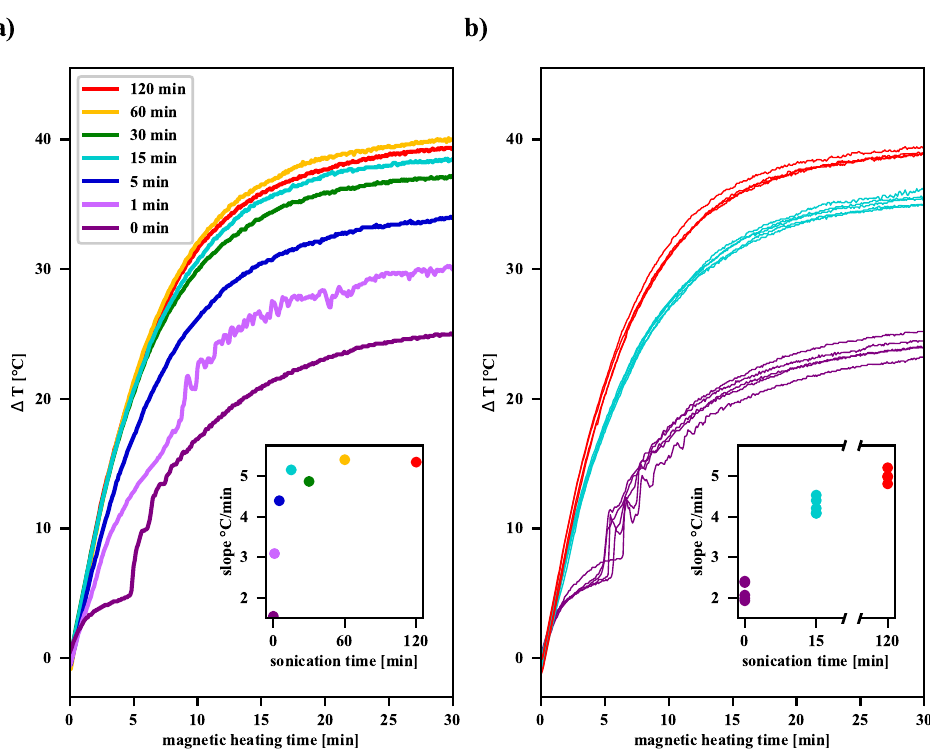
Figure 4. Both panels show how ∆ T changes during the RFMH process for suspensions treated with ultrasound. Before the sample was placed in the coil of the RFMF generator, so its temperature was equalized with the temperature of the water entering the cooling system; therefore, the starting ∆ T was around zero. Panel ( a ) shows the dependency of ∆ T on the time of magnetic heating for suspensions treated with ultrasound. The series of curves on the panel ( b ) presents the spread of the ∆ T curves for the three series of measurements, where each series of samples was taken from the same vial. Each series of samples was taken from the same vial (with the suspension not sonicated or sonicated for 15 or 120 min, respectively). In both insets, the initial slopes of the ∆ T curves were determined during magnetic heating in the range of 30–90 s when the ∆ T increase rate was almost linear. Measurements on the two panels were taken on different days, but all samples were from the same